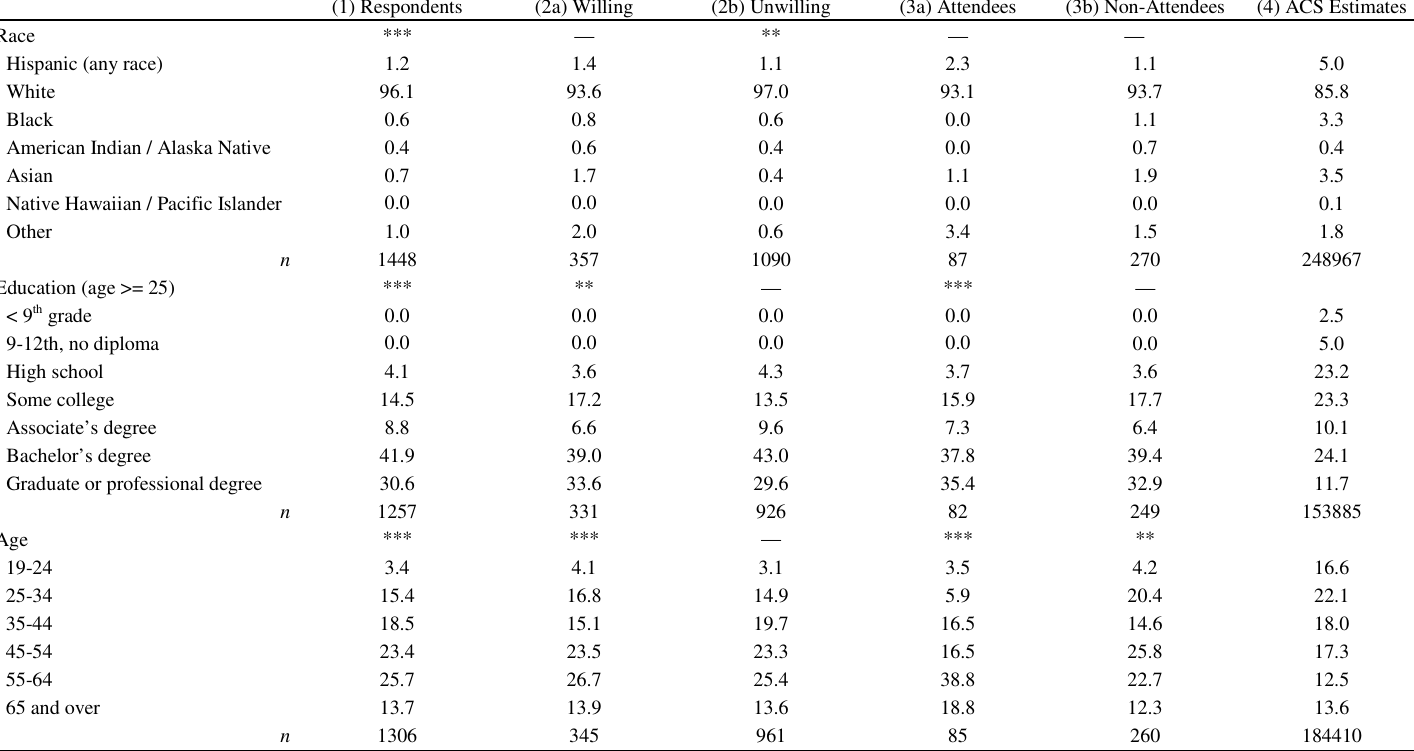
Table 3. Comparison of recruitment respondents, willing and unwilling participants, event attendees and nonattendees, and Census demographics (Study